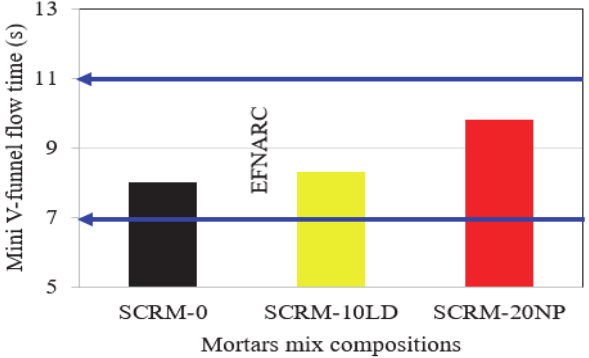
Figure 5: Mini V-Funnel flow time for SCRMs.